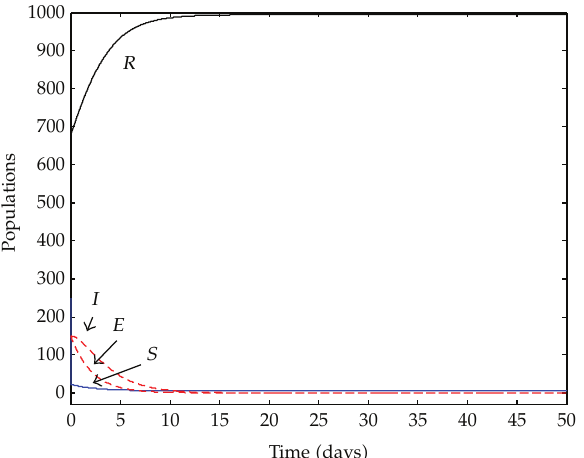
Figure 5: Evolution of the populations with vaccination and unknown